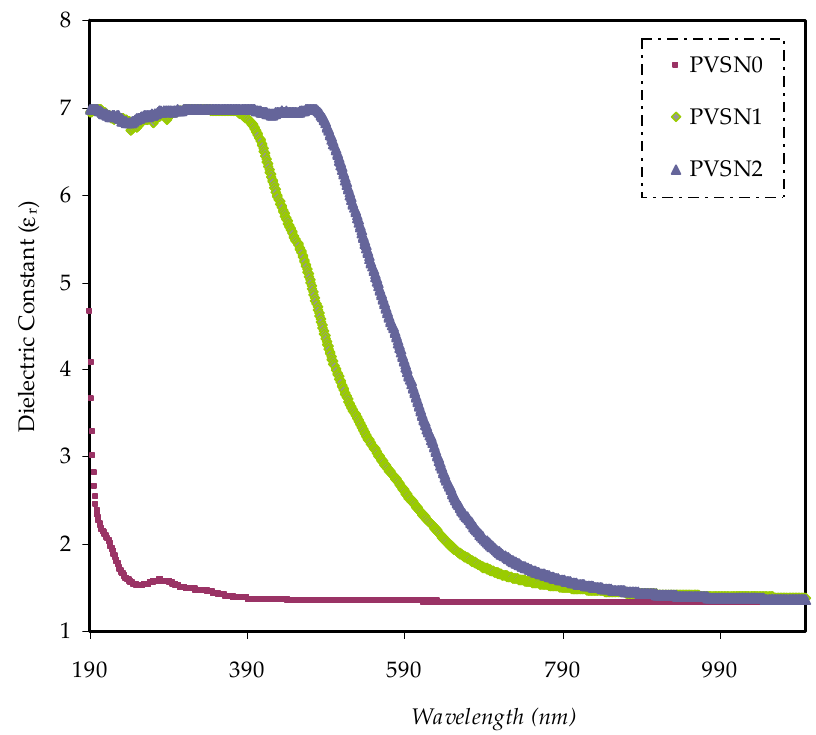
Figure 10. Dielectric constant versus wavelength for PVA and loaded films.